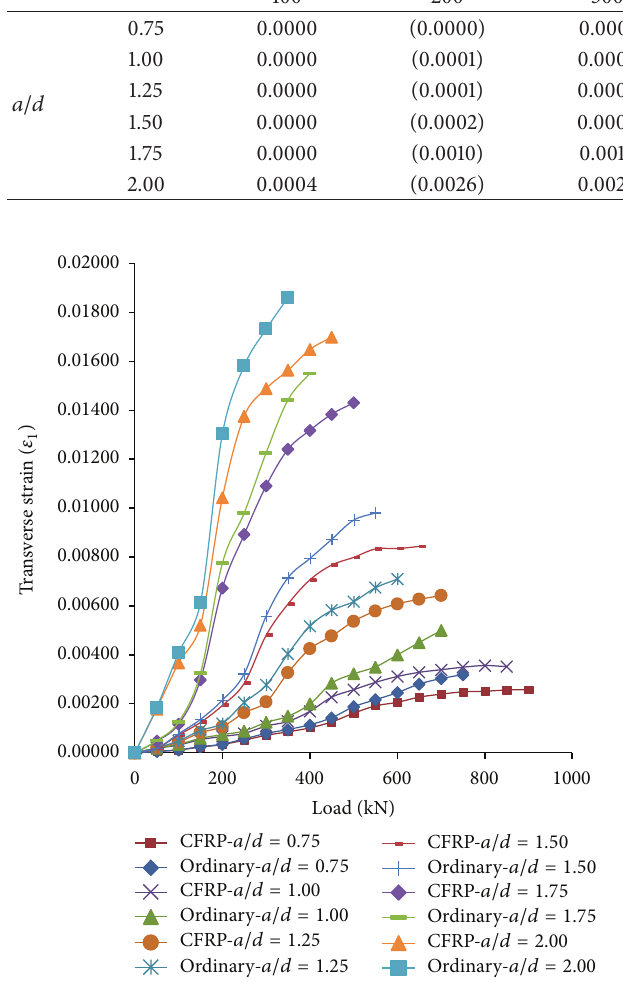
Figure 5: Load-transverse strain curves of unstrengthened and CFRP-strengthened RC